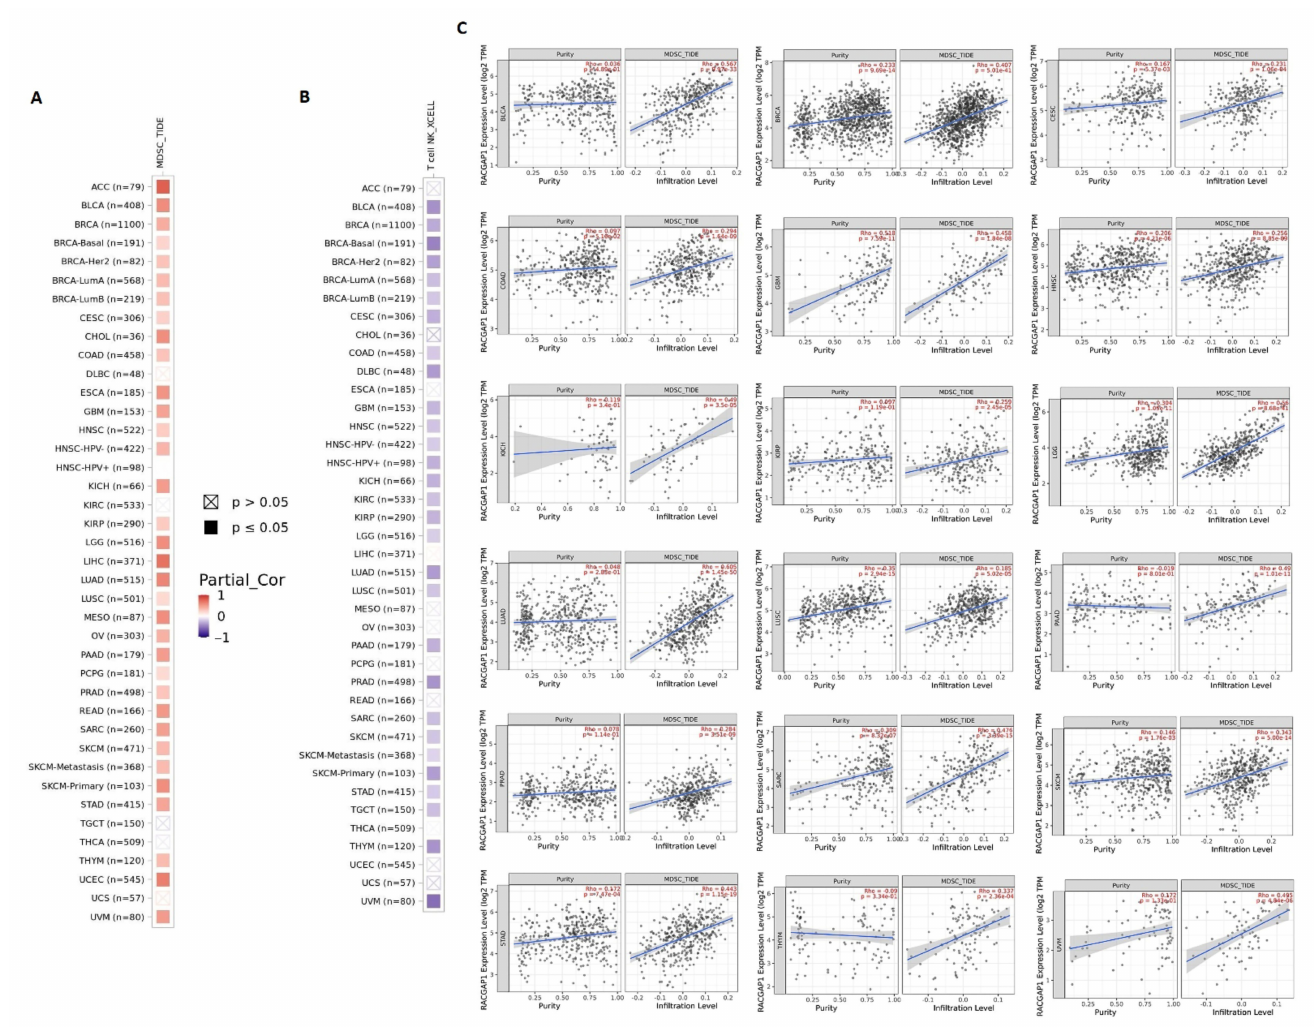
Figure 7. The correlation between RACGAP1 expression level and infiltration of ( A ) myeloid-derived suppressor cells (MDSC) and ( B ) natural killer T cells in a panel of human cancers; ( C ) scatter plots demonstrate the correlation between the expression of RACGAP1 and the infiltration level of